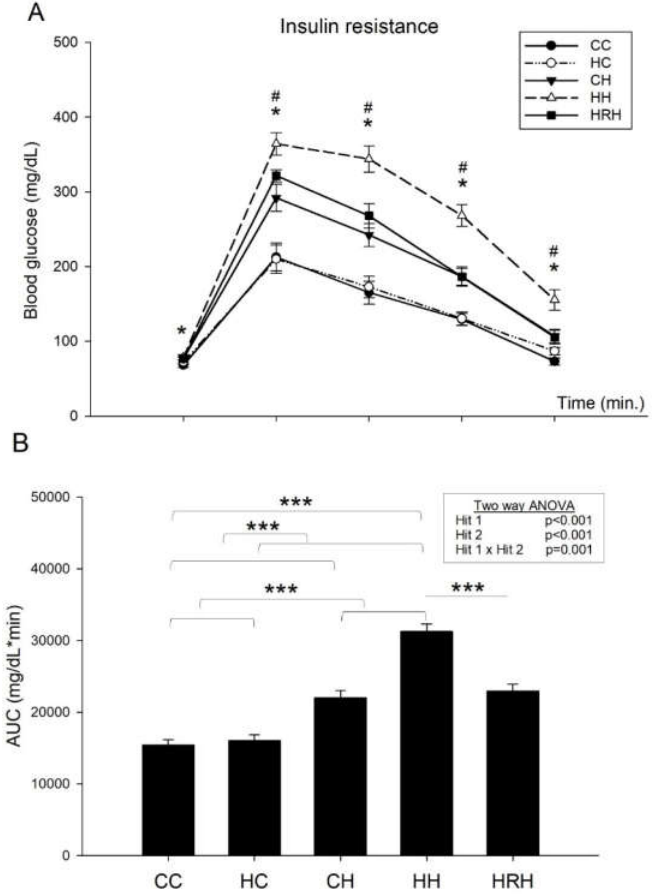
Figure 5. Plasma glucose levels of post-stimulation tests. ( A ) Intraperitoneal glucose tolerance test. * p < 0.05 CC vs. HH; # p < 0.05 HH vs. HRH ( B ) Glucose area under the curve (AUC). Data were